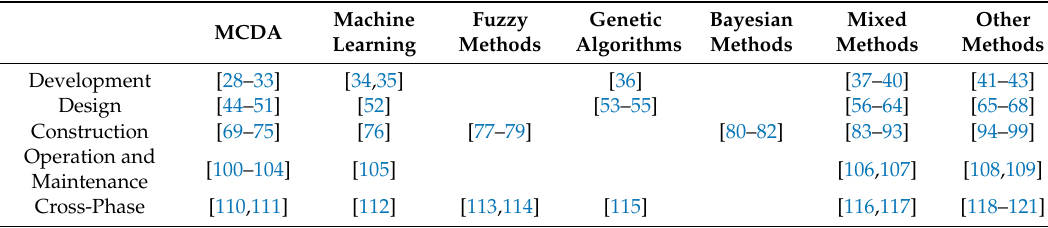
Table 2. Categorization of articles with methods and